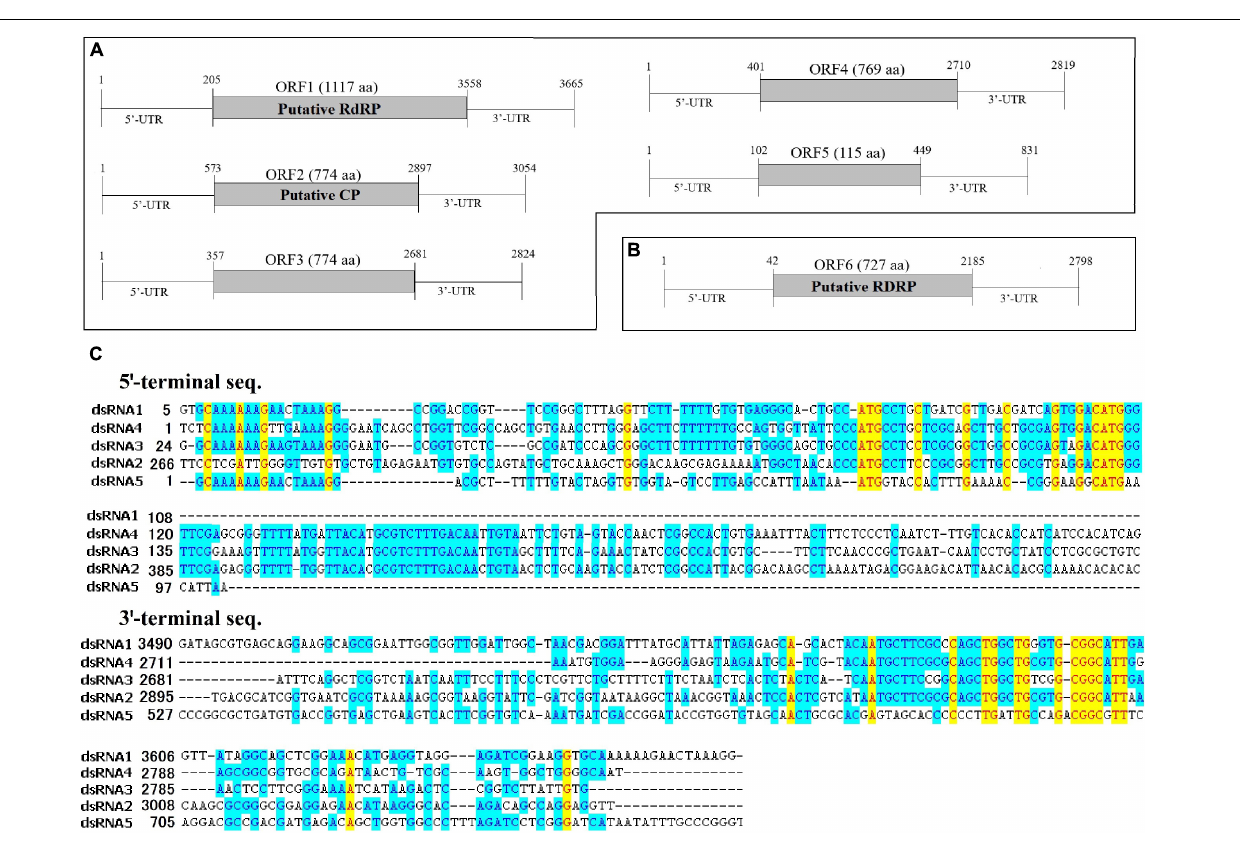
FIGURE 2 | The genome organization and the terminal structure of AaCV1-QY2 and AaMV1. (A,B) A schematic diagram of the genome organization of AaCV1-QY2 (A) and AaMV1 (B) . The boxes and lines represent the open reading frames (ORFs) and untranslated regions (UTRs), respectively. RdRp represents viral RNA-directed RNA-polymerase domain; CP represents coat protein. (C) Multiple sequence alignments of the 5’- and 3’-terminal regions of the coding strands of the five AaCV1-QY2 dsRNA